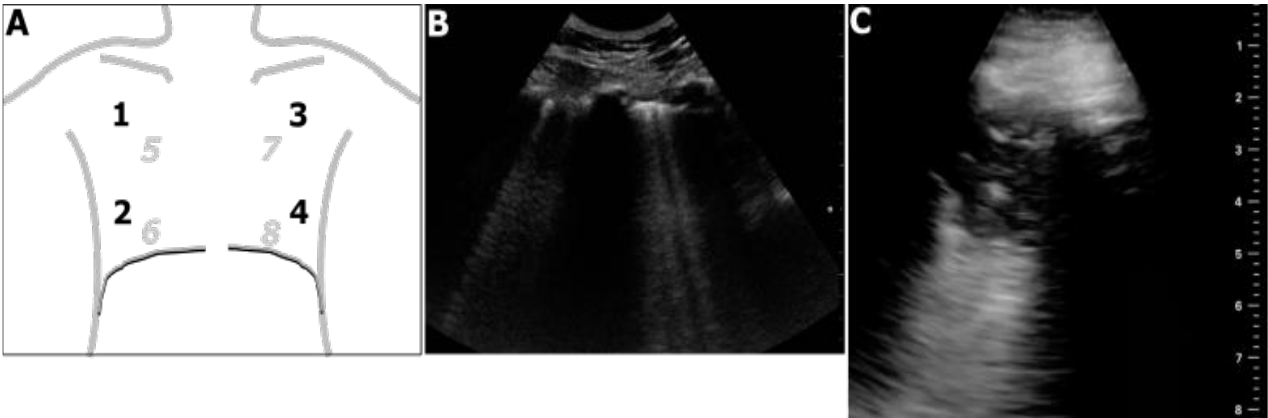
Figure 1. Panel ( A ): Lung areas for the calculation of the modified LUS score. 1: right upper antero-lateral area; 2: right lower antero-lateral area; 3: left upper antero-lateral area; 4: left lower antero-lateral area; 5: right upper posterior area; 6: right lower posterior area; 7: left upper posterior area; 8: left lower posterior area. Panel ( B ): representative LUS image showing B-lines. Panel ( C ): representative LUS image showing a lung consolidation.